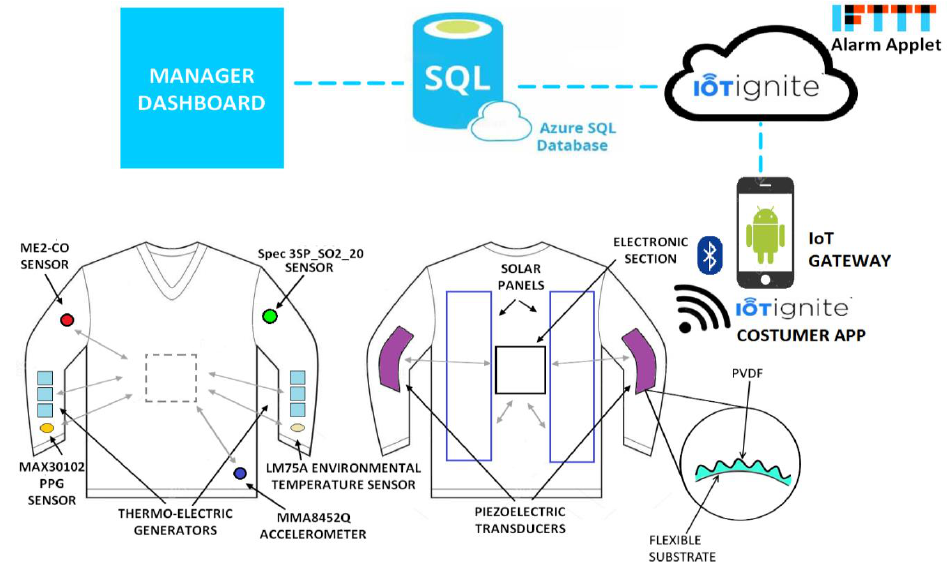
Figure 2. Schematic representation of the system architecture for monitoring environmental and biophysical parameters in workplaces based on the self-powered smart garment.